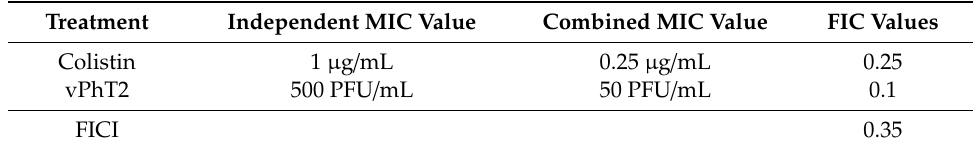
Table 9. Susceptibility of Acinetobacter baumannii host strain AB183 to colistin in combination with bacteriophage